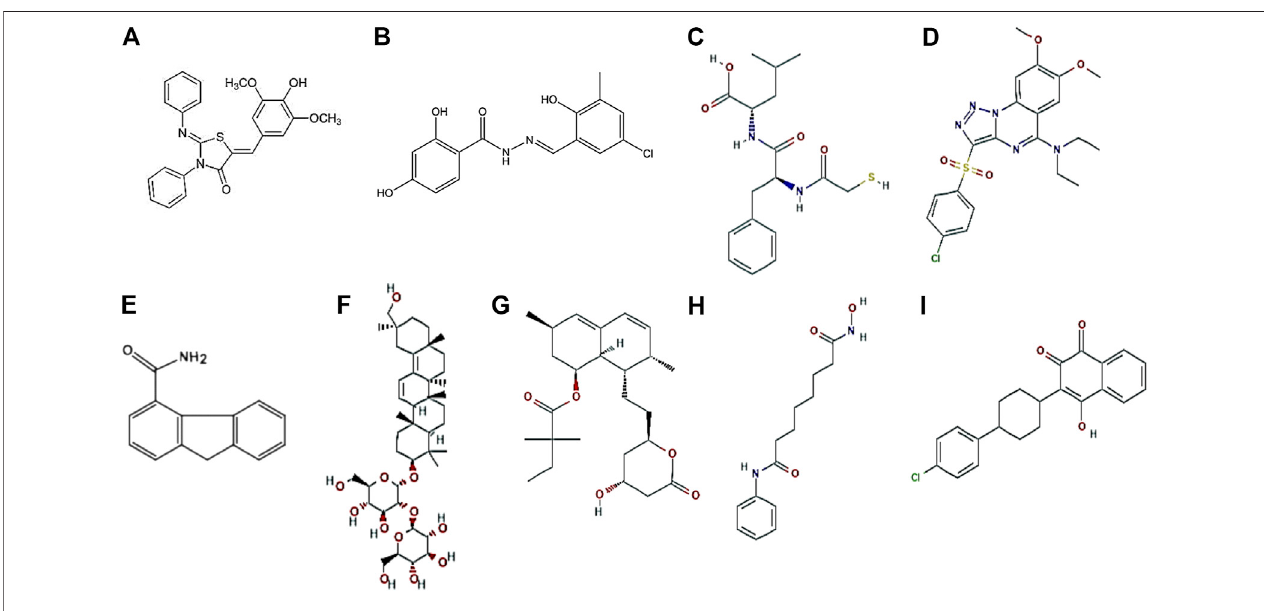
FIGURE 5 | Representative structures of small molecules. 2-Imino-5-Arylidene thiazolidinone (Felise et al., 2008) (A) , INP0341 (Nordfelth et al., 2005) (B) , 2- mercaptoacetyl-L-phenylalanyl- L -leucine (Kessler et al., 1982) (C) , Targocil (Farha et al., 2015) (D) , Pseudolipasin A(Lee et al., 2007) (E) , Glycyrrhizin (Ji et al., 2016) (F) , Simvastatin (Jensen et al., 2016) (G) , Suberoylanilide hydroxamic acid (Choi and P fl um, 2012) (H) , and Atovaquone (Nixon et al., 2013) (I) .